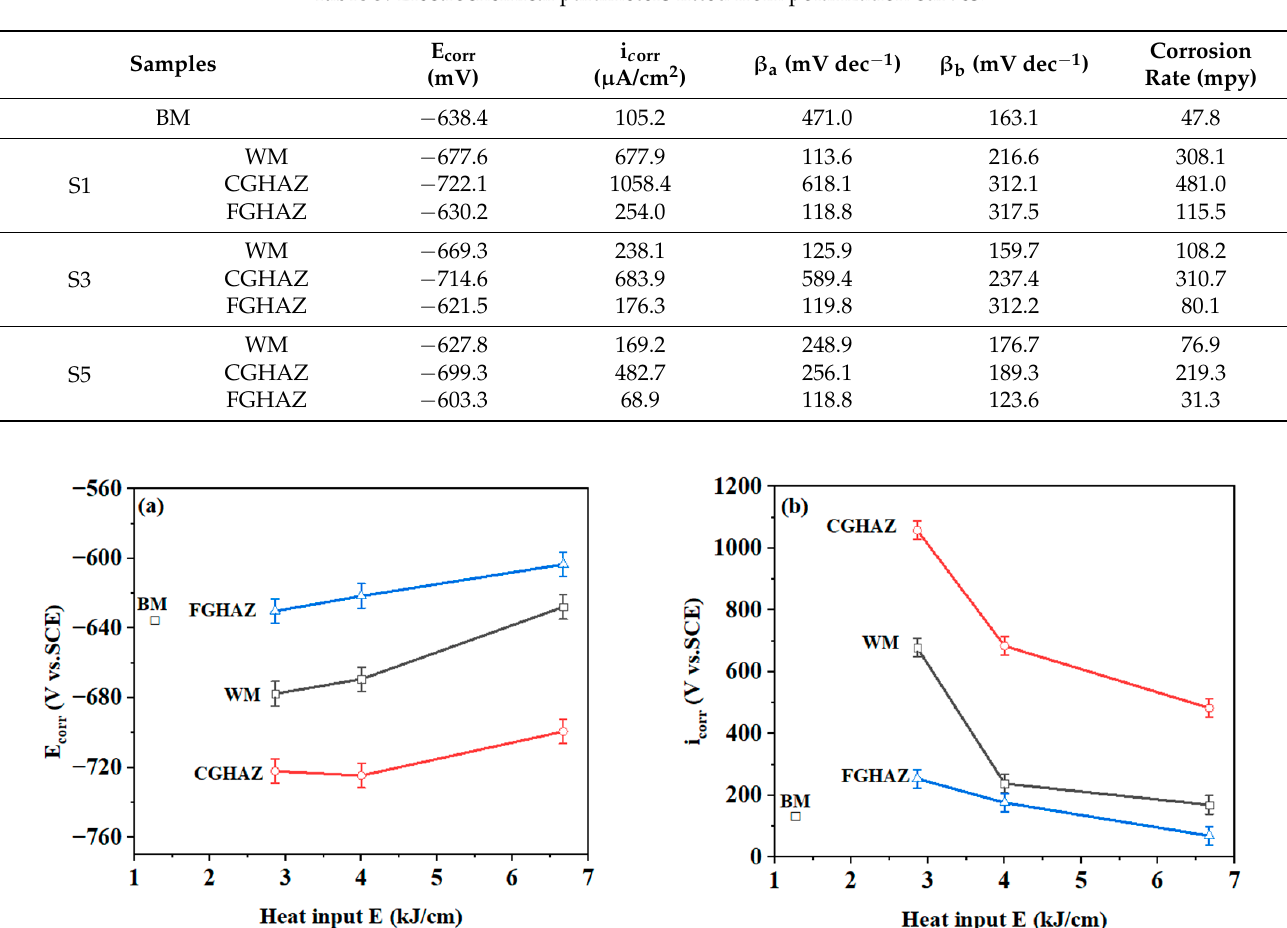
Figure 11. The fitted results of E corr and i corr extracted from the potentiodynamic polarization curves for different samples: ( a ) heat input and E corr change line chart; ( b ) heat input and i corr change line chart. Table 3. Electrochemical parameters fitted from polarization curves.